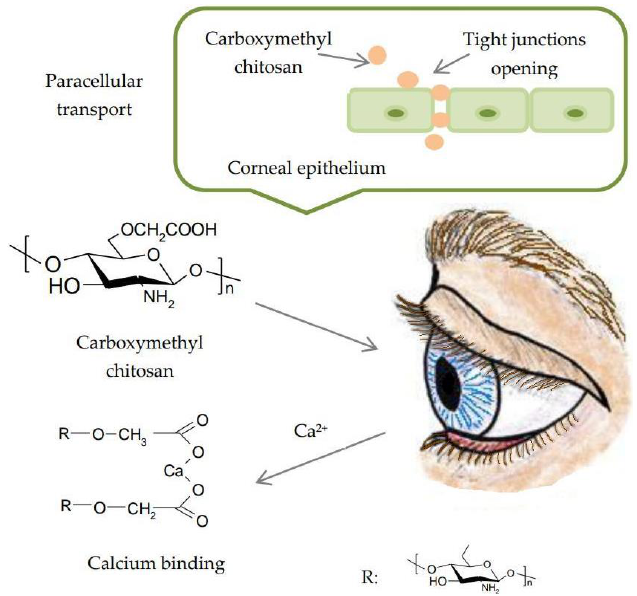
Figure 11. Paracellular transport of carboxymethyl chitosan through the corneal epithelium. Reproduced with permission from Ref. [84]. Copyright © Elsevier,